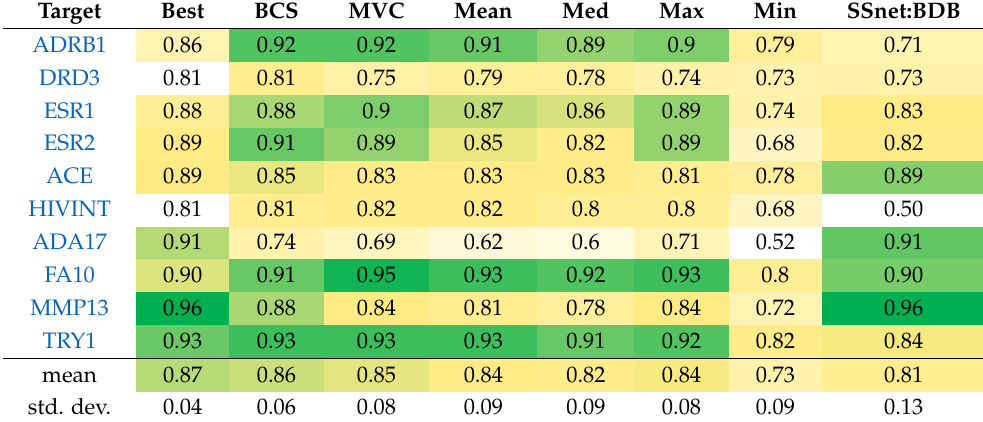
Table 4. AUCROC comparision on consensus scores. Target